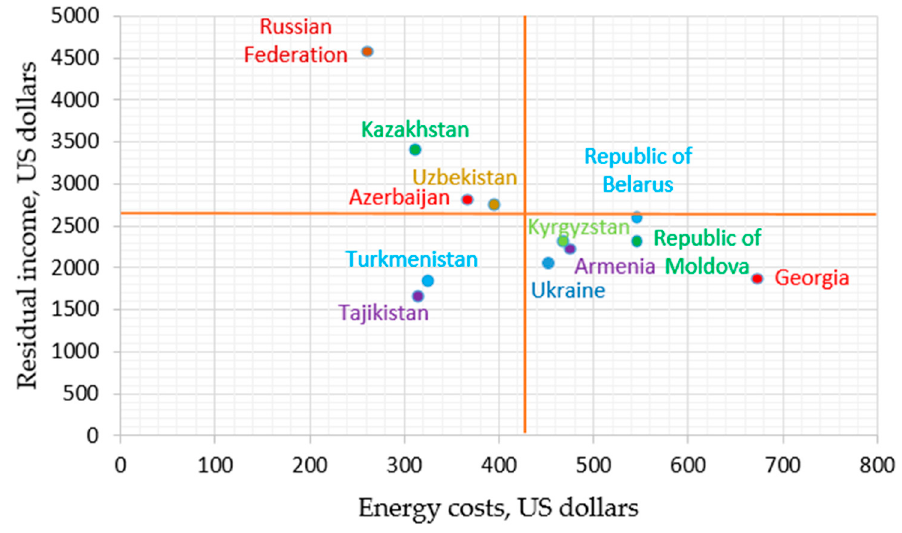
Figure 1. Indicators for assessing energy supply of the population of the EECCA countries. Source: authors’ elaboration.